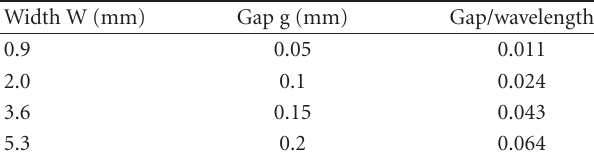
Table 2: The dimensions of 50Ohm